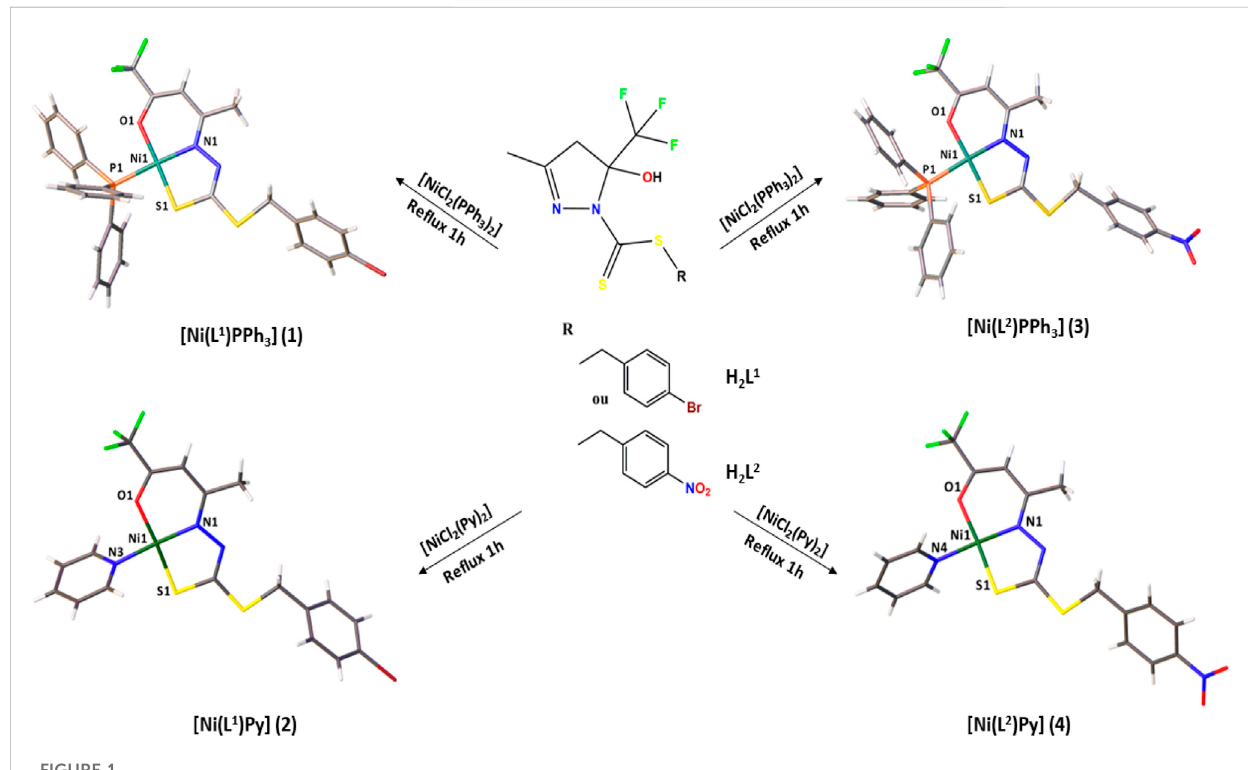
Synthesis of the Ni(II) complexes (1 –